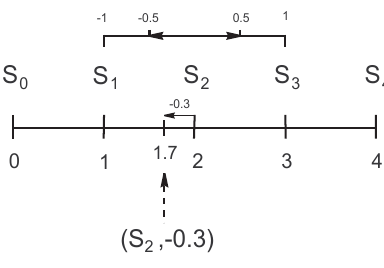
Fig. 1. Symbolic translation of a